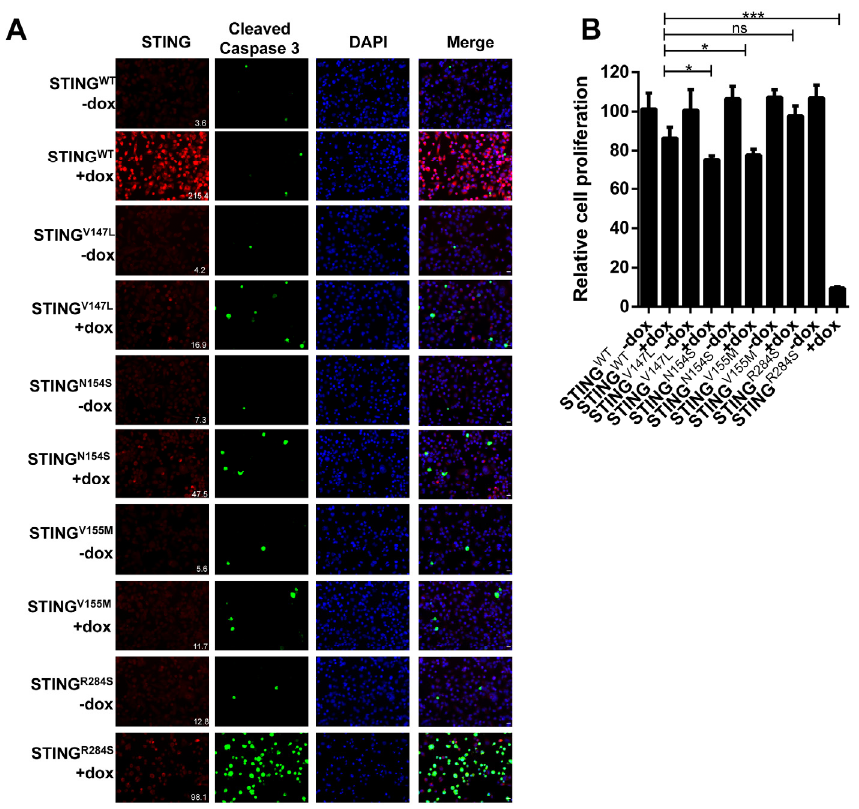
Figure 2. Identification of highly effective STING gain-of-function mutants. ( A ) MIA PaCa-2 cells stably expressing STING WT , STING V147L , STING N154S , STING V155M or STING R284S were treated with or without 5 µg/mL dox for 48 h. The cells were stained for STING (Red) and Cleaved Caspase-3 (Green). The mean fluorescence intensity of the STING images was quantified using ImageJ software and denoted at the bottom right corner. Scale bar: 20 µm. ( B ) MIA PaCa-2 cells stably ex-